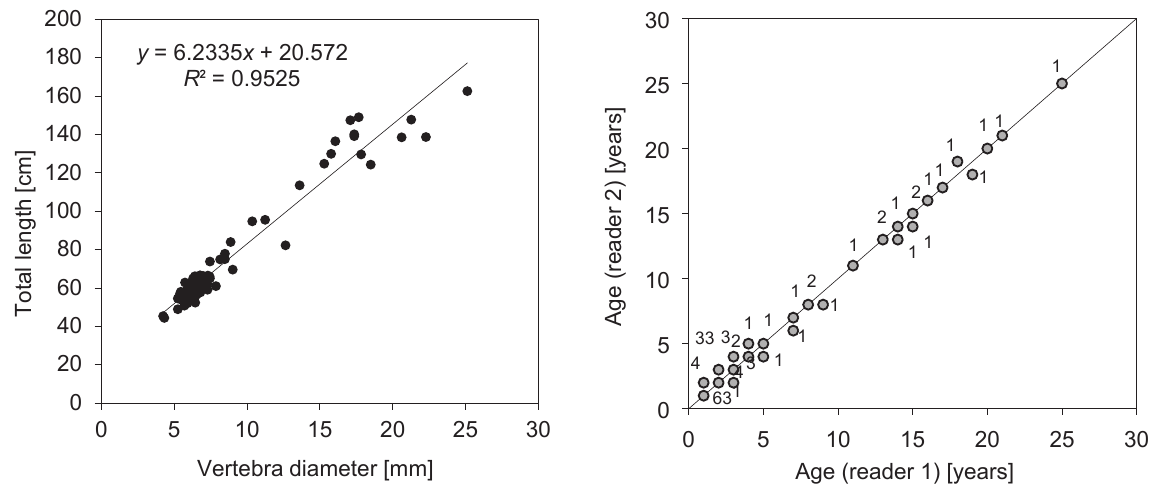
Fig. 4. The relation between the vertebral diameter and the total length of Mustelus mustelus from the Gulf of Iskenderun, north-eastern Mediterranean Sea